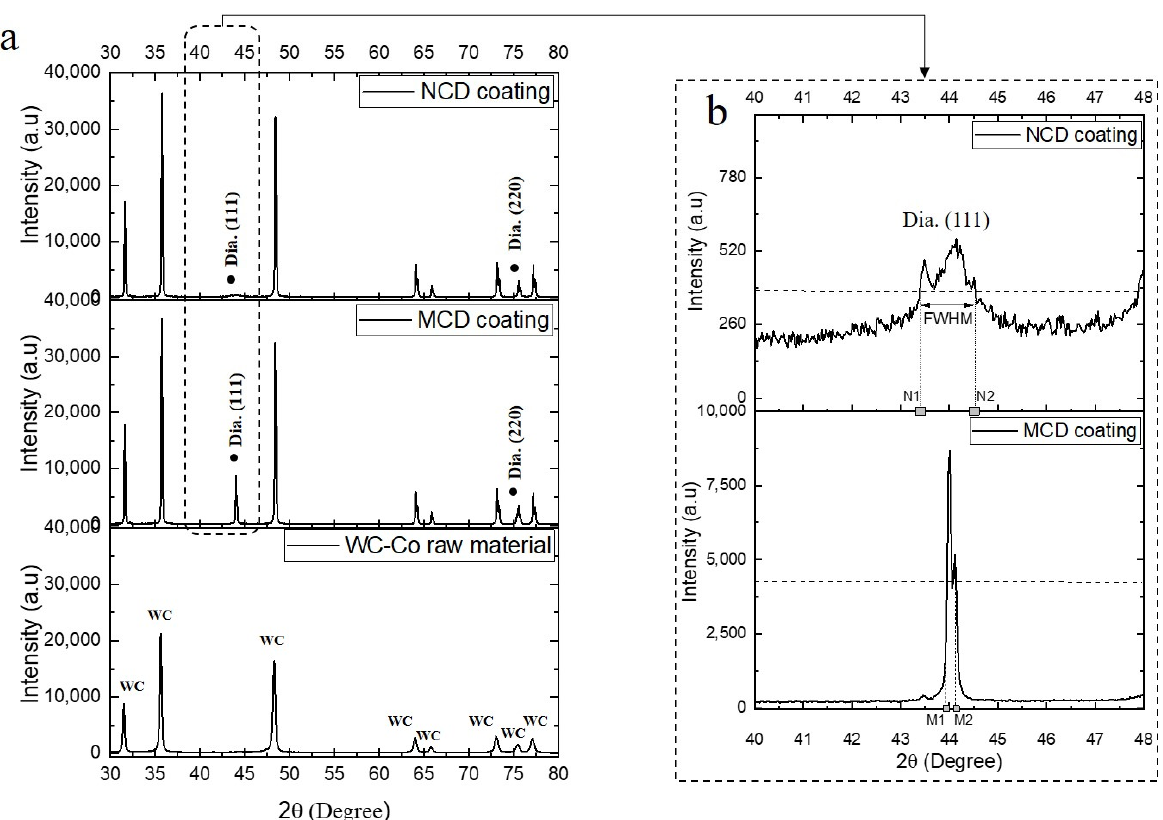
Figure 1. XRD patterns of ( a ) WC-Co substrate and MCD and NCD coating films. ( b ) Magnified view of crystalline plane (111). (FWHM, full width at half maximum).